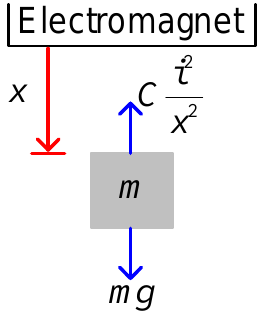
Figure 1. Schematic diagram of an MSS.